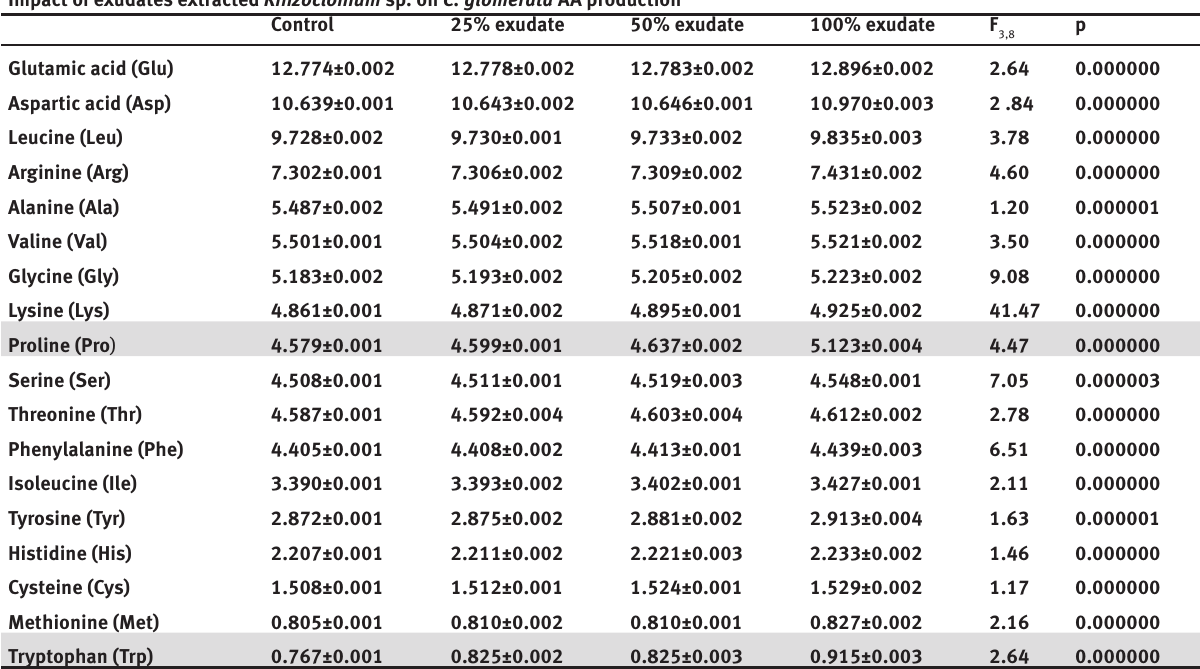
Table 5: The content of amino acids (AA) in Cladophora glomerata biomass. (g·100g -1 of total proteins; df=3; bold - statistically significant, p<0.05; gray selection - fluctuation in the content of amino acid >